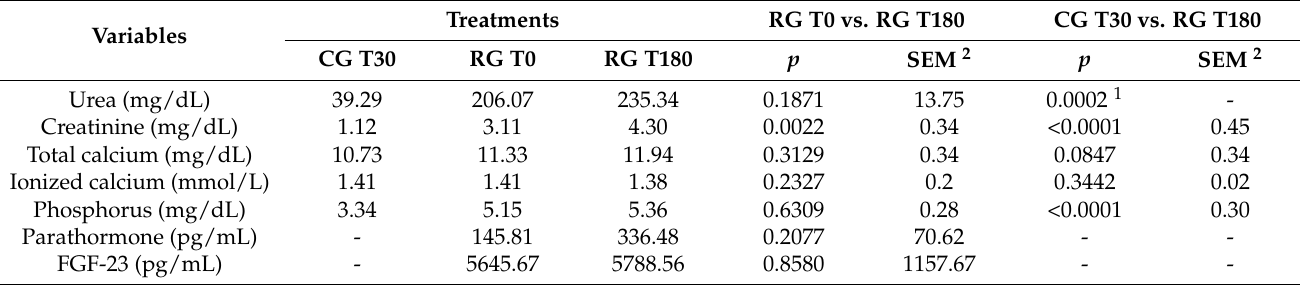
Table 1. Serum concentrations of urea, creatinine, total calcium, ionized calcium, phosphorus, parathormone, and fibroblast growth factor 23 (FGF-23) of dogs with chronic kidney disease before (RG T0) and after 180 days (RG T180) of therapeutic renal diet intake and healthy dogs (CG T30) after 30 days of therapeutic renal diet